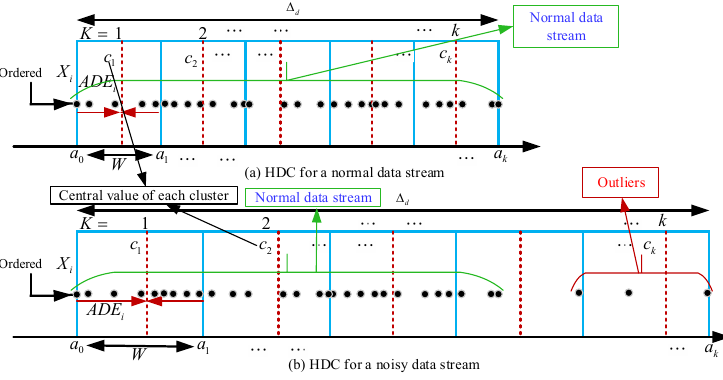
Figure 3. A graphical representation of the histogram-based data clustering (HDC) technique. ( a ) The HDC performs clustering for a “normal” data stream; ( b ) The HDC performs clustering for a “noisy” data